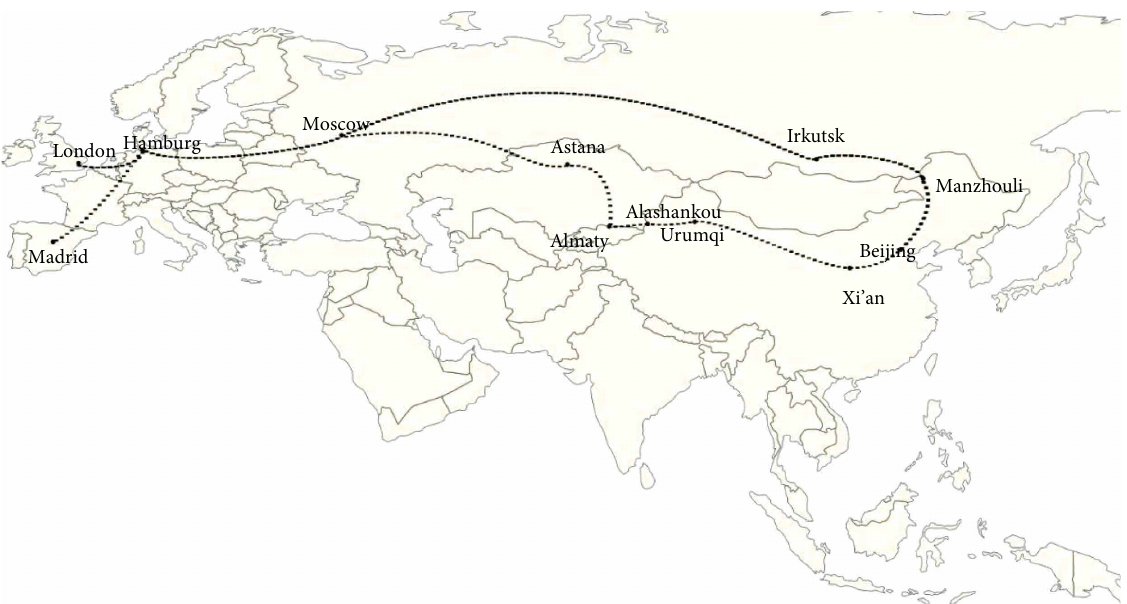
Figure 3: CRE transportation routes from China to